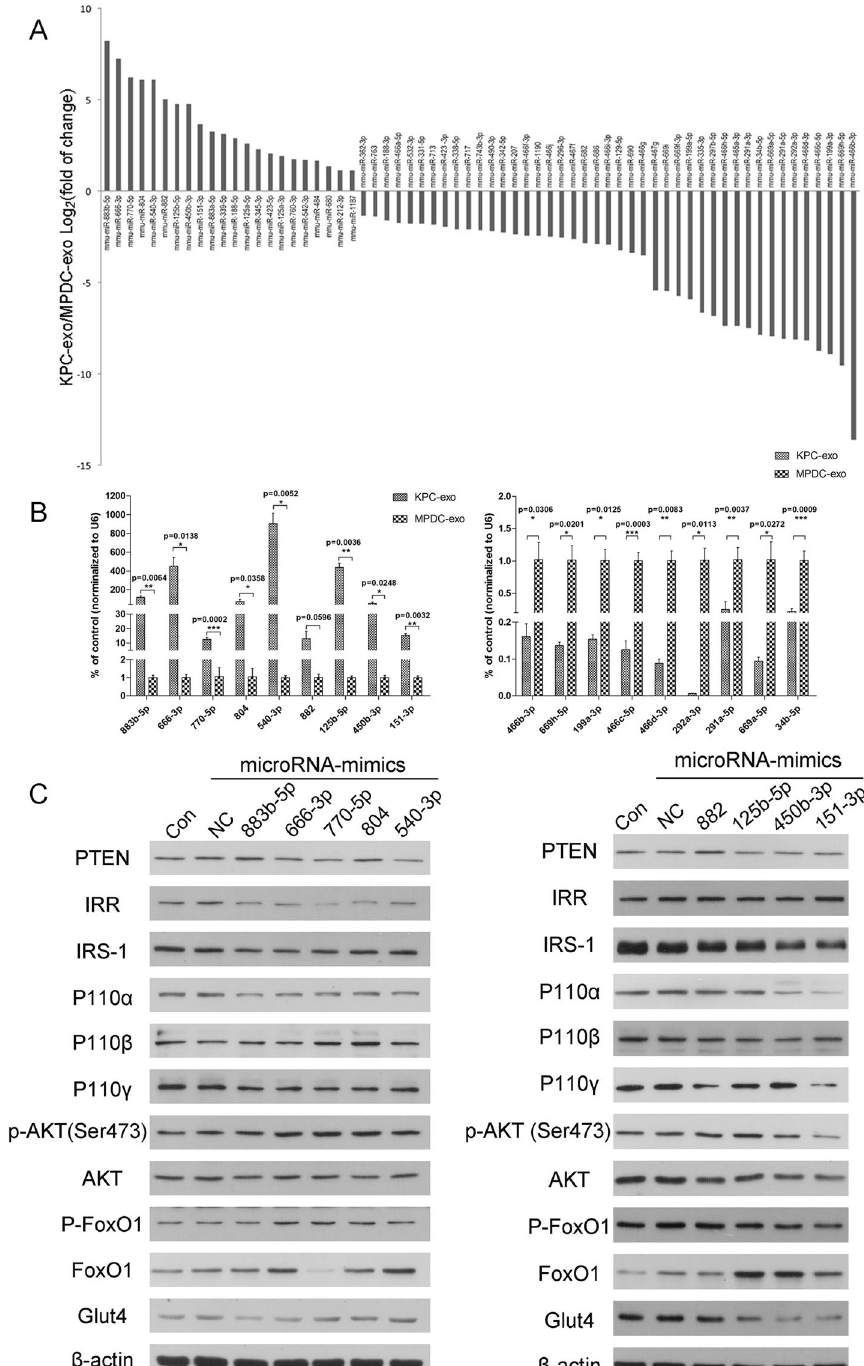
Figure 7. Comparison of miRNA profiles of the two types of exosomes according to the microarray analysis and validation by RT-qPCR and immunoblotting. ( A ) The bar graph shows differentially expressed miRNAs in KPC-exosomes compared with MPDC-exosomes. ( B ) The first nine miRNAs from each subgroup (increased & decreased) were validated by RT-qPCR. U6 was used as an endogenous control. ( C ) The effects of the first nine highly expressed miRNAs on the signalling